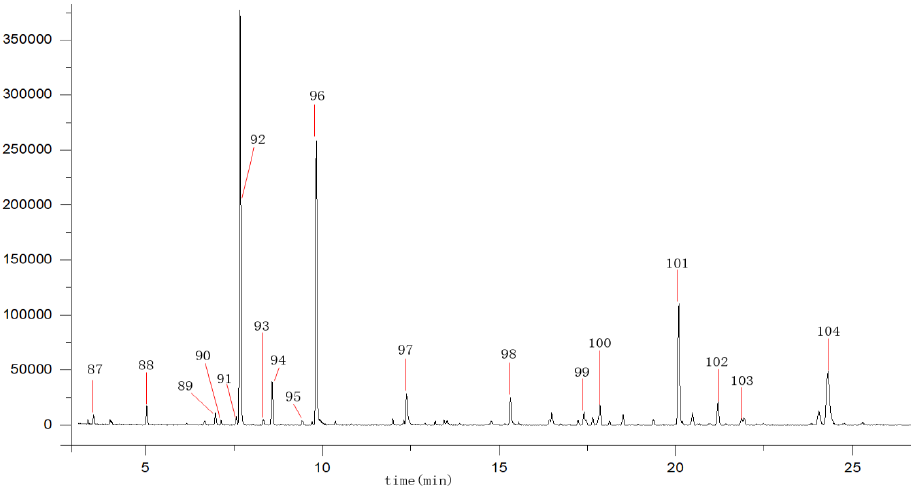
Figure 2. Total ion chromatgraphy of the volatile oils from Aurantii fructus. Table 2. Identification of 18 aromatic constituents from Aurantii fructus by the GC-MS method.